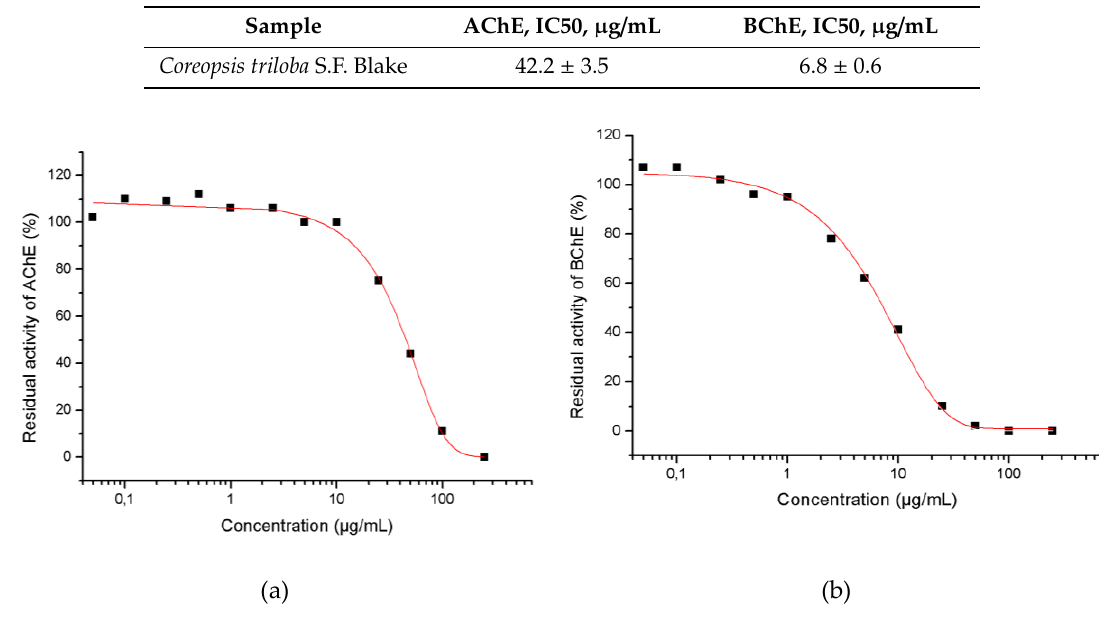
Figure 3. IC 50 values for Coreopsis triloba S.F. Blake essential oil vs. (a) acetylcholinesterase (AChE) and (b) butyrylcholinesterase (BChE). IC 50 : half maximal inhibitory concentration.